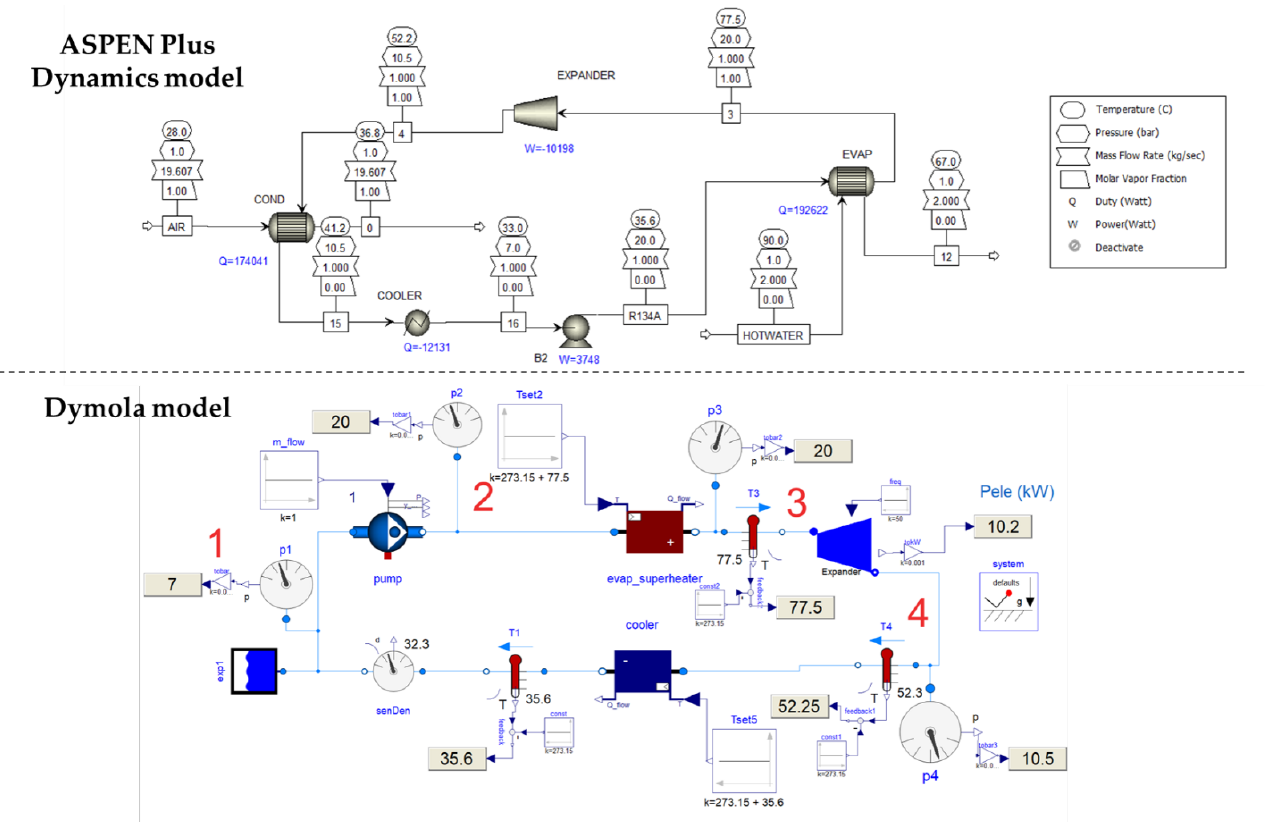
Figure 4. Verification of the ORC model developed in Dymola ( below ) against the ASPEN Plus Dynamics model ( above ).